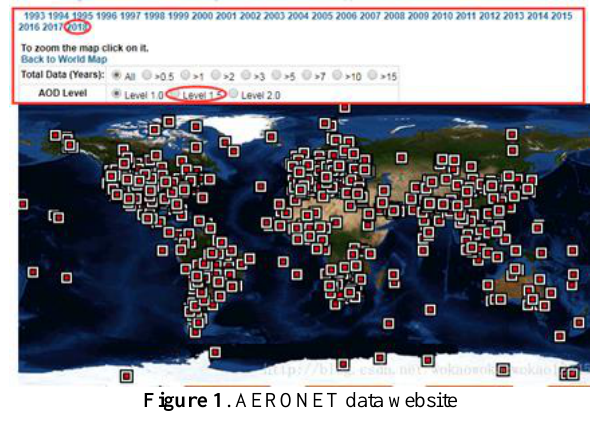
Figure 1 . AERONET data